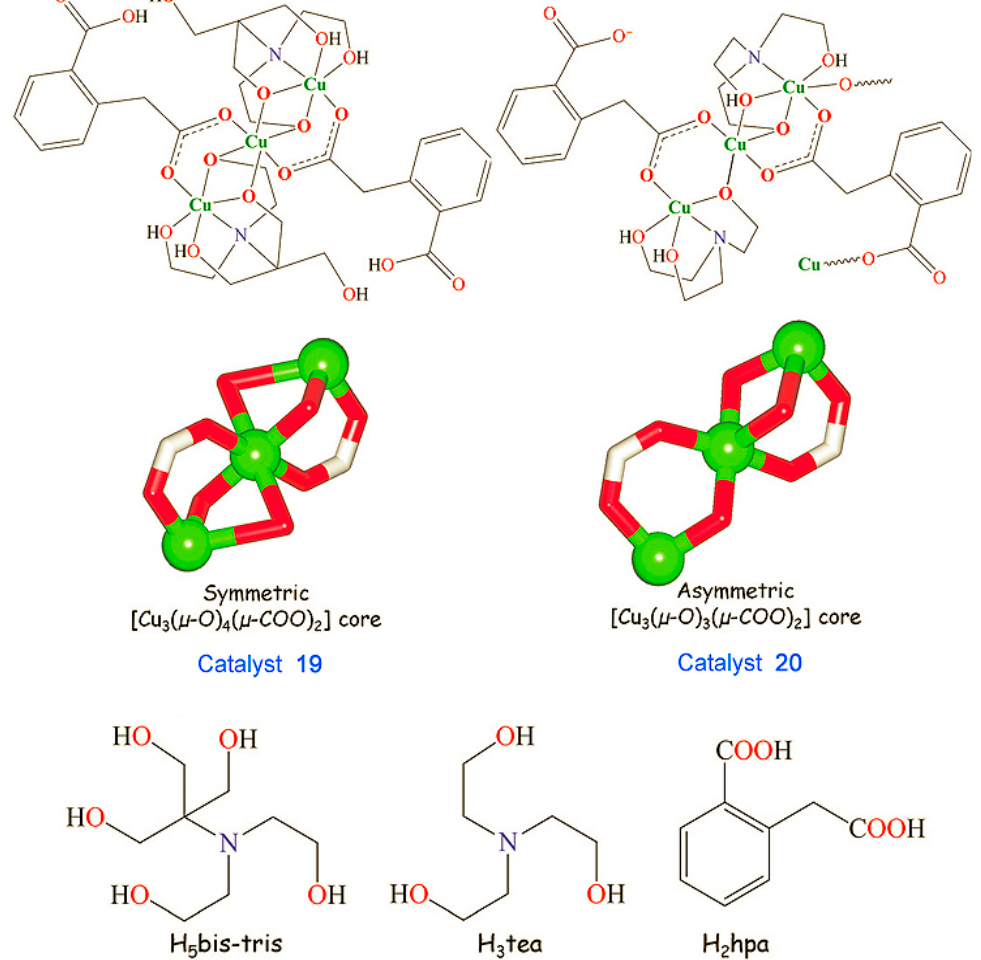
Figure 14. Catalysts [Cu 3 ( μ 2 ‐ H 3 bis ‐ tris) 2 ( μ 2 ‐ Hhpa) 2 ] ∙ H 2 O ( 19 ) and [Cu 3 ( μ 2 ‐ H 2 tea) 2 ( μ 2 ‐ hpa)( μ 3 ‐ hpa)] n ( 20 ) bearing distinct tricopper(II) cores where H 3 tea is triethanolamine, H 2 hpa is homophthalic acid, H 5 bistris is bis(2 ‐ hydroxyethyl)amino ‐ tris(hydroxymethyl)methane. Adapted from Ref. [241].